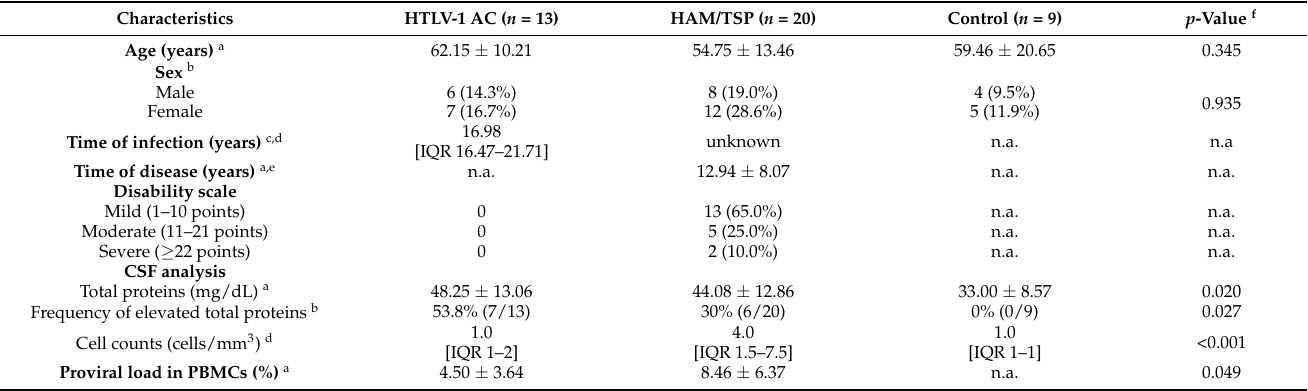
Table 1. Characteristics of the study